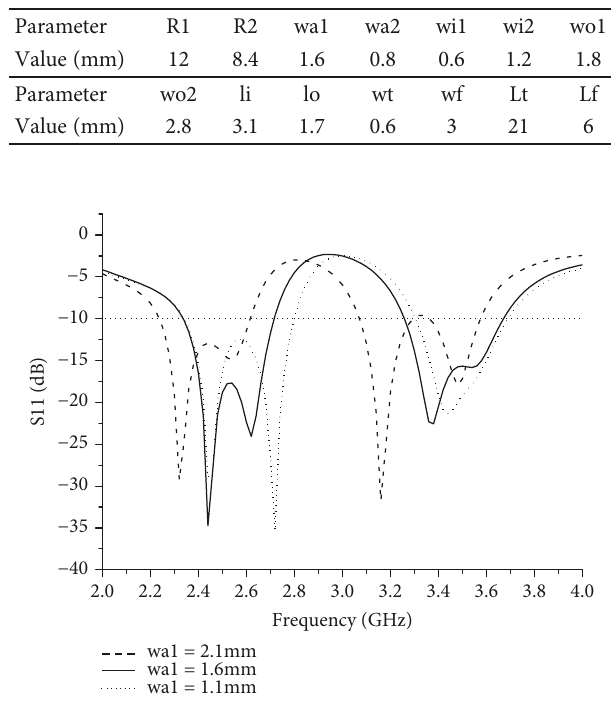
Figure 5: Simulated S